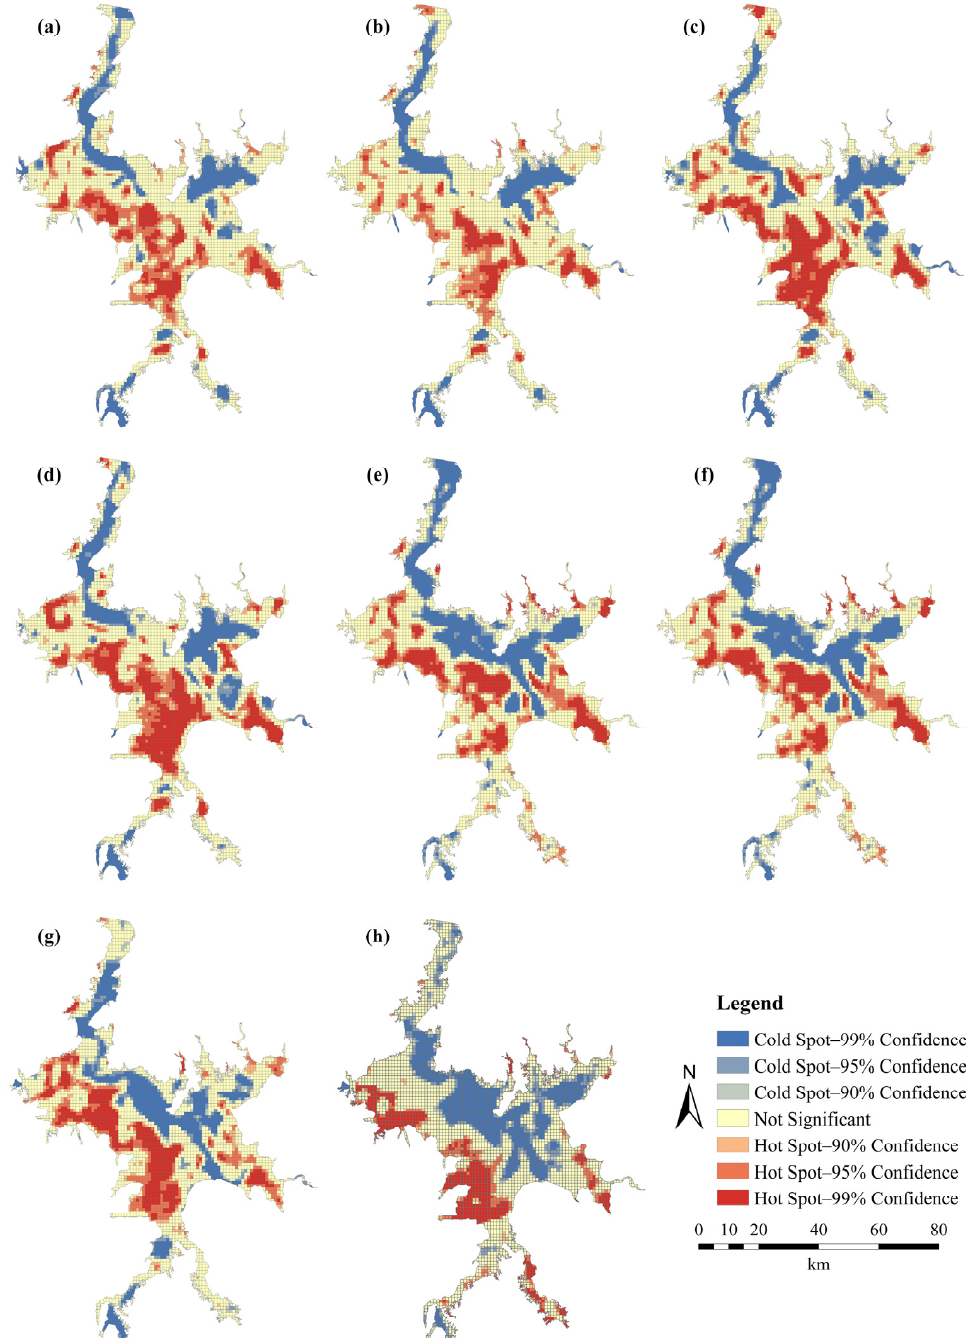
Figure 8. Hot and cold spots of the stabilities of crane habitats within various water level intervals: